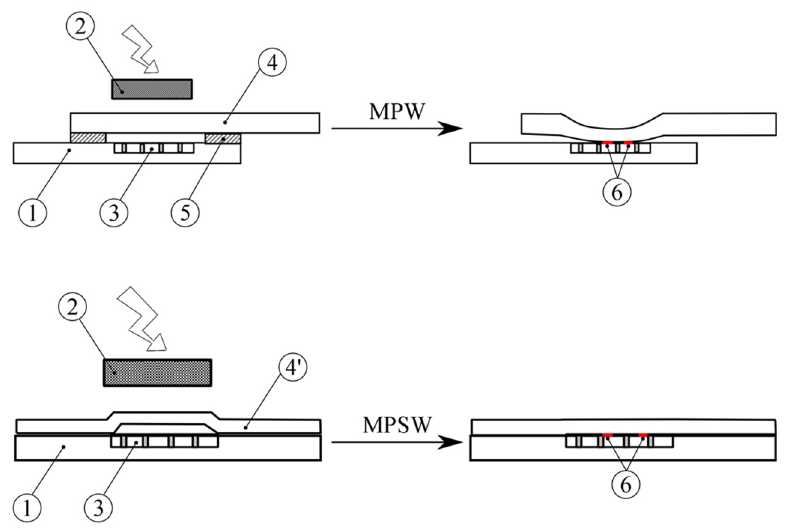
Figure 2. Configuration 1–(1) FRPC; (2) coil; (3) metallic insert; (4–4 ′ ) flyer metal; (5) insulators; (6) welding area [50].